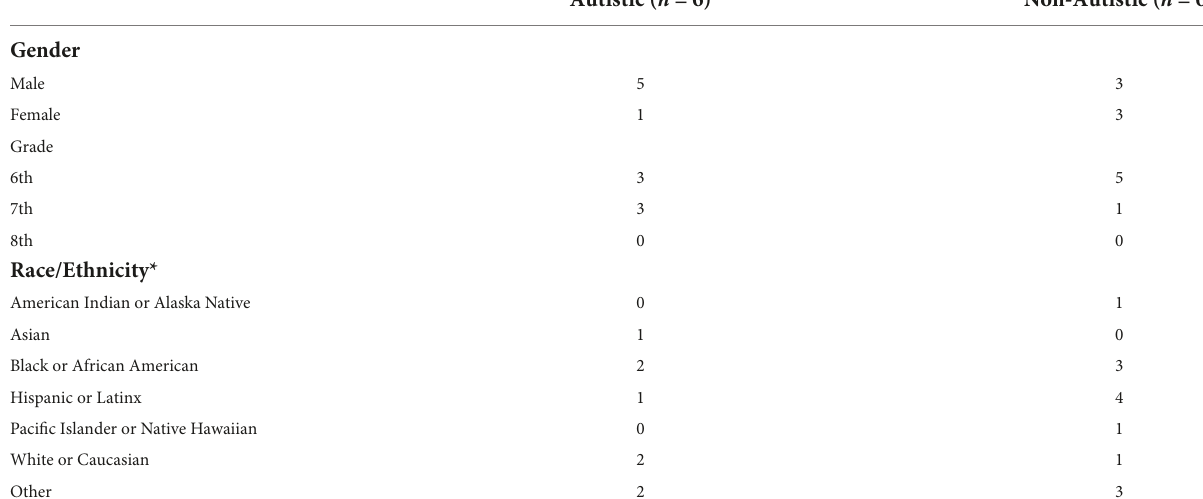
TABLE 1 Participant